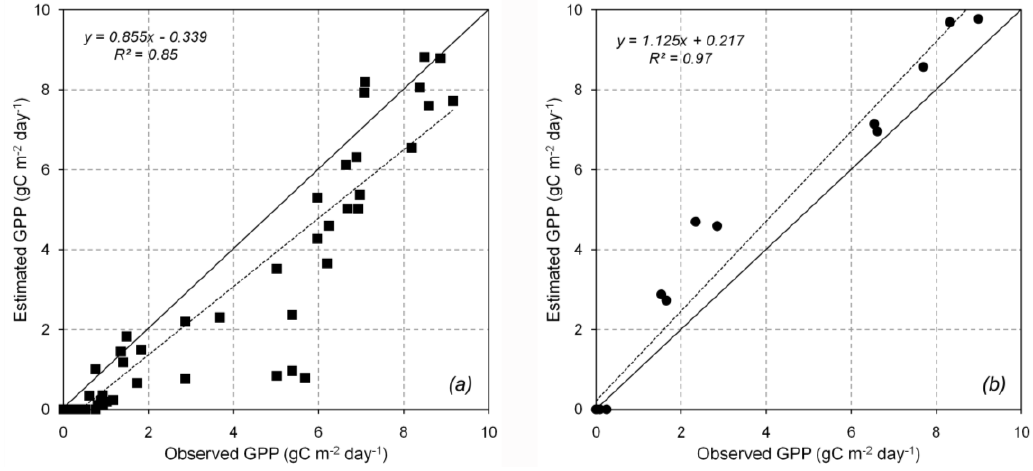
Figure 7. Comparison of estimated GPP and observed GPP from flux tower at (a) Takayama and (b) Hitsujigaoka, respectively. The dash line is the linear regression between the estimated and observed value. At Takayama, the linear equation is y = 0.855x − 0.339, and at Hitsujigaoka is y = 1.125x + 0.217,